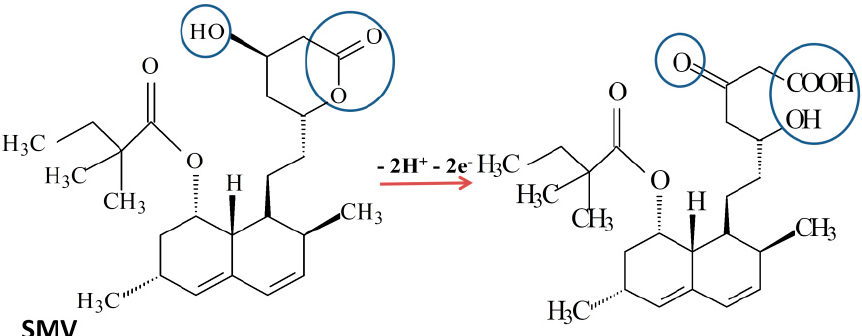
Figure 4. Proposed global mechanism for the electrochemical oxidation of SMV.